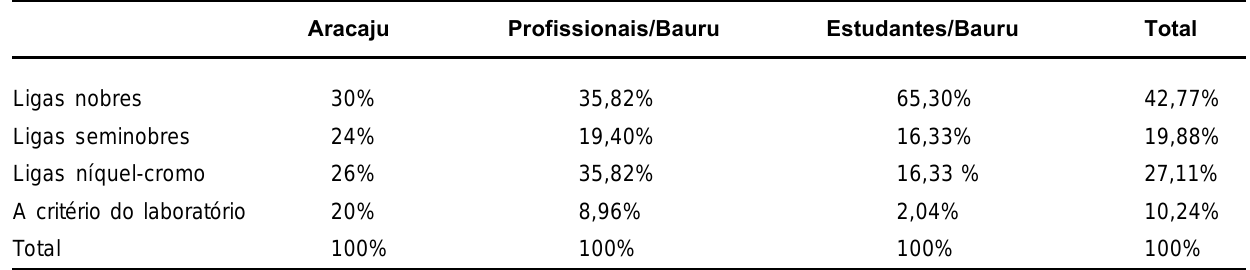
TABELA 13 - Se seus dentes posteriores necessitassem de uma prótese fixa, que tipo de liga você usaria em sua metalo-